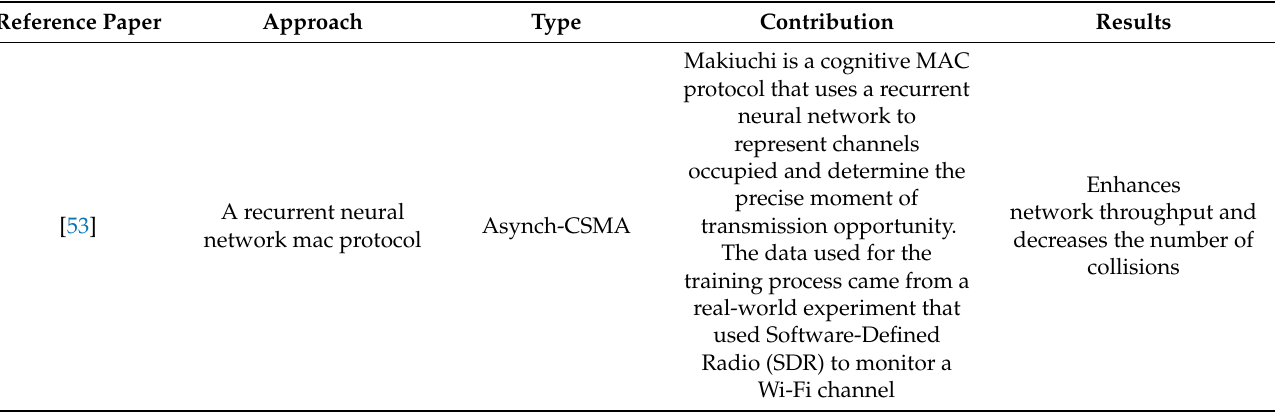
Table 5. Machine learning-based